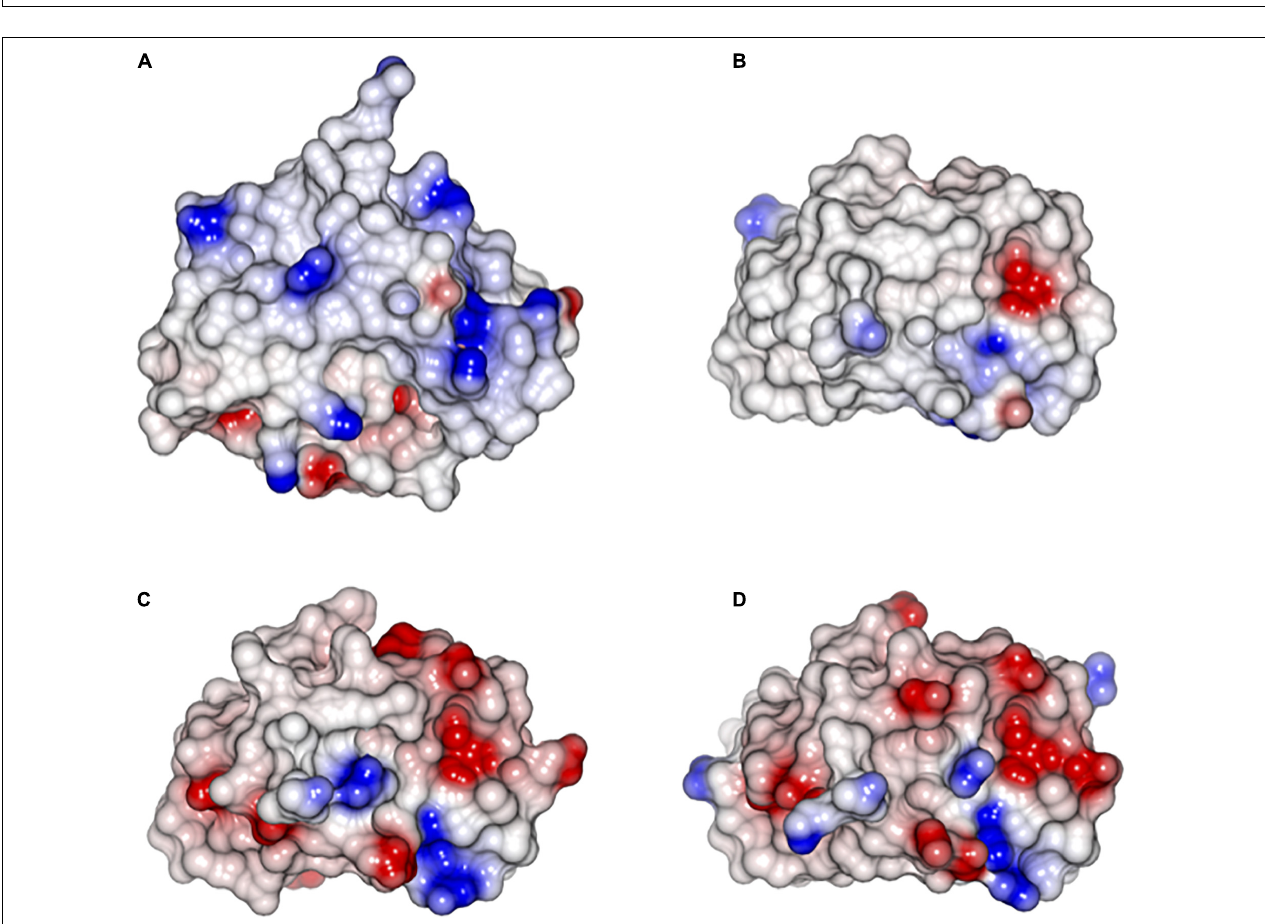
FIGURE 4 | Alignment of SUGARWINs and BARWIN. The alignment (ClustalW) of the full sequences, including the signal peptide, highlights a histidine at alignment position 44 (His11) in BARWIN and SUGARWIN1. SUGARWINs 2, 3 and 4 show the replacement of histidine by asparagine at alignment position 44.